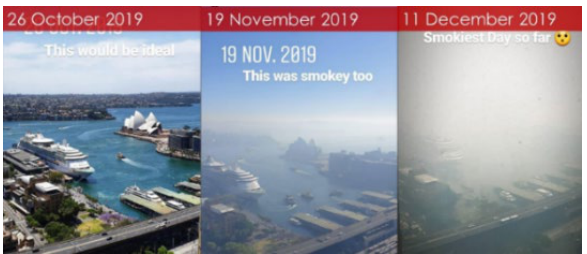
Figure 1: Impact of Bushfire in NSW, Sydney from October